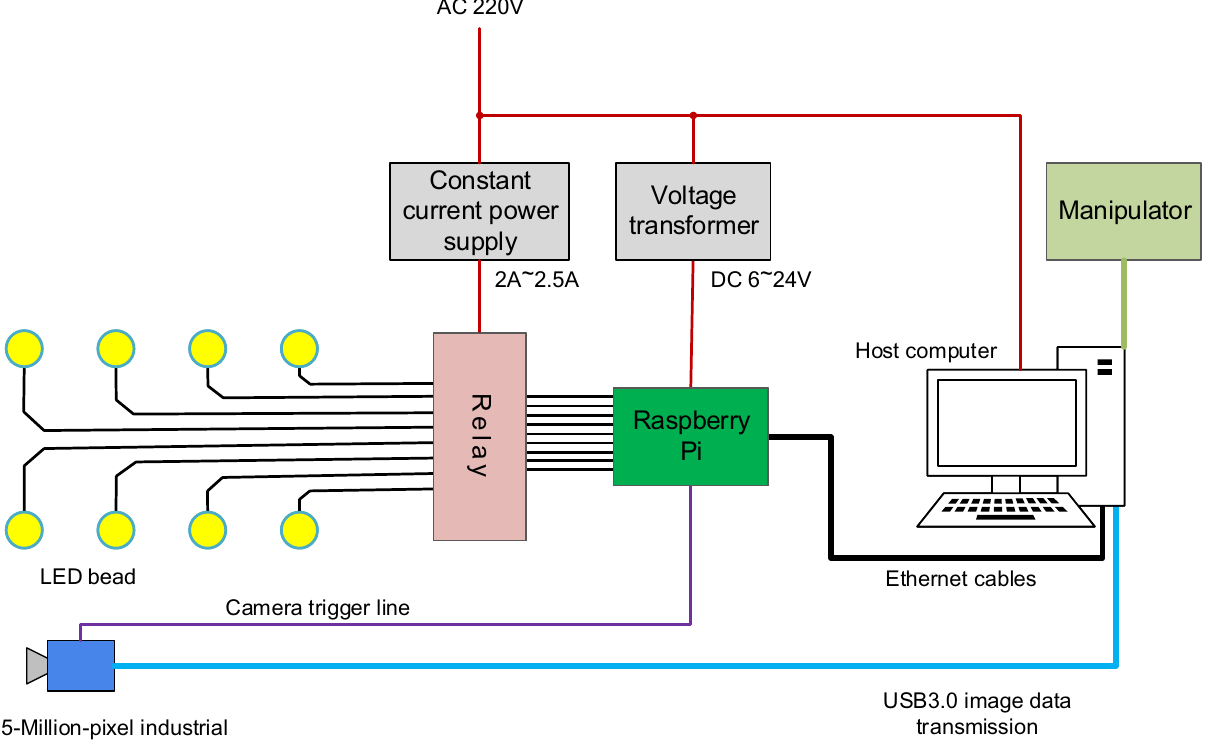
Figure 4. The control scheme for hardware. The host computer controls the communication among the manipulator, the Raspberry Pi, and the industrial camera. The Raspberry Pi controls the operation of the LED